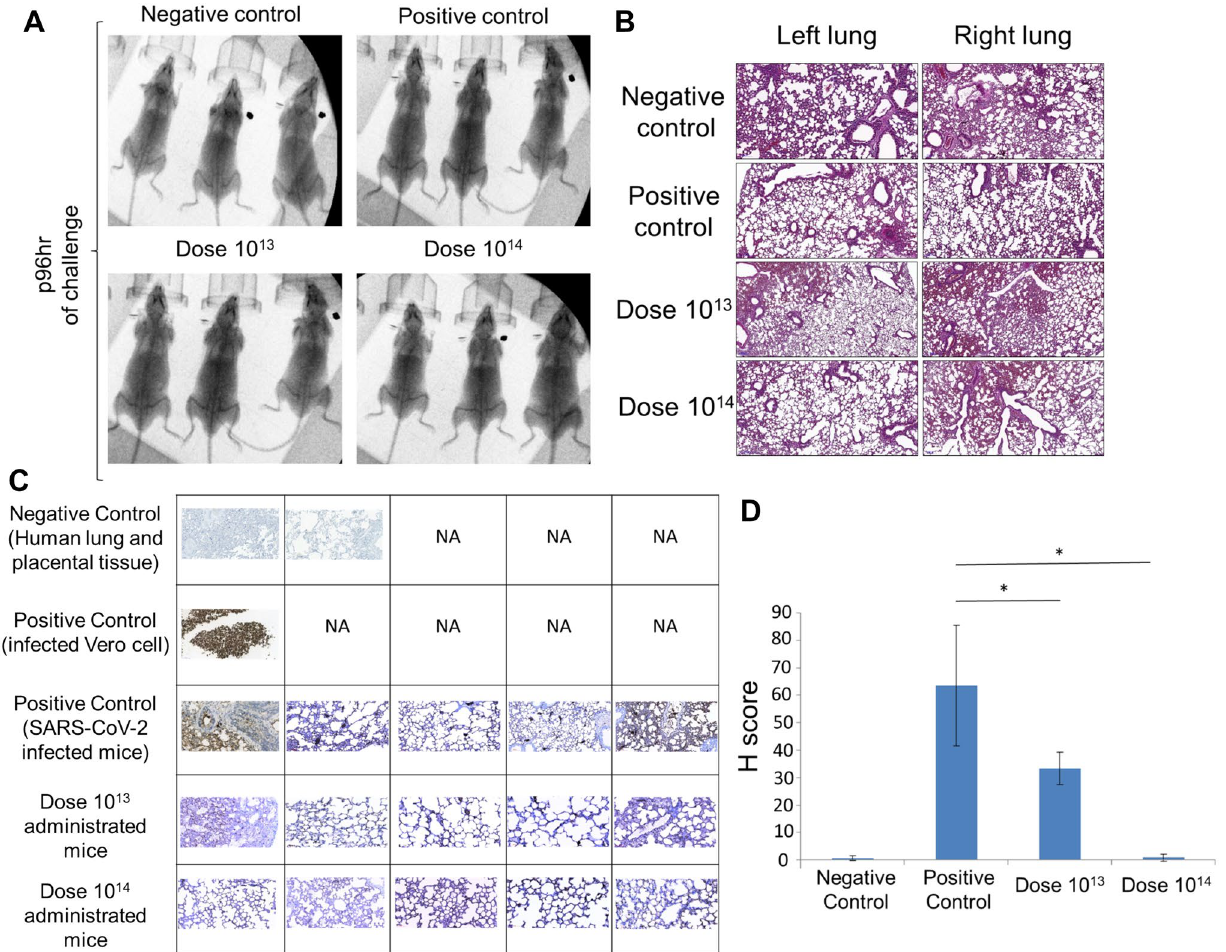
Figure 4. X-ray imaging and histopathology analysis of the lungs of SARS-CoV-2 infected mice. ( A ) X-ray imaging and ( B ). Histopathology analysis of the mice groups that were negative control (uninfected and no vaccination), positive control (only infection), dose 10 13 group, and dose 10 14 group (vaccinated and infected). ( C ) Immunohistochemistry analysis of the lung tissues. Paraffin block was prepared from SARS-CoV-2 cell culture and lung tissues of the challenge assay mice groups. Sections of 4 microns made from paraffin block were studied immunohistochemically with SARS/SARS-CoV-2 coronavirus nucleocapsid monoclonal antibody (B46F) (ThermoFisher Scientific, US). Infected Vero cells were used as positive control; Human lung and placental tissue were used as negative controls (50 µm). NA not applied. ( D ) Immunohistochemistry analysis (H-score) of the lung tissues. * p <